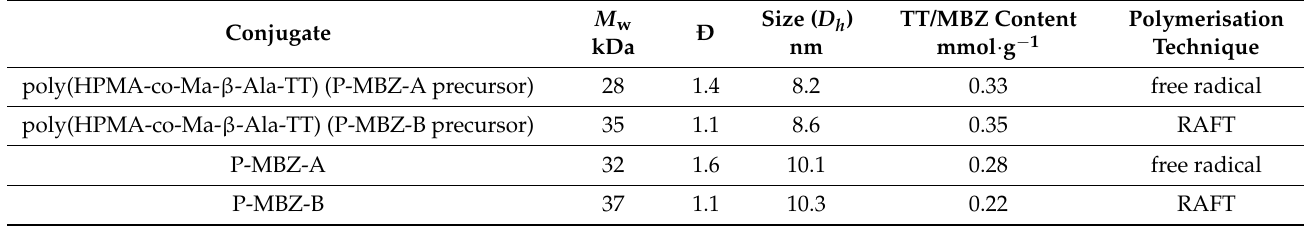
Figure 2. Structure of the HPMA copolymer conjugate bearing MBZ bound through a 6-aminohexanoate-based ester linkage. Table 1. Characteristics of MBZ polymer conjugates and their precursors.